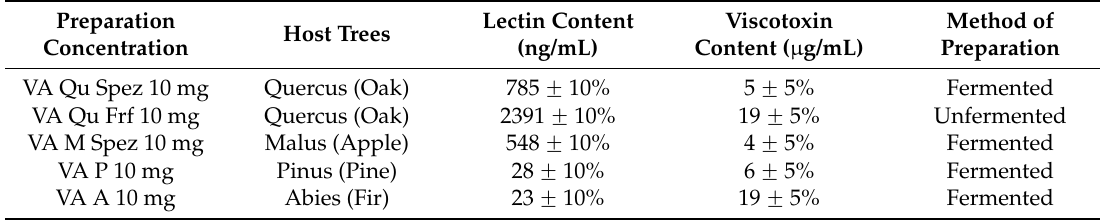
Table 1. Composition of VA